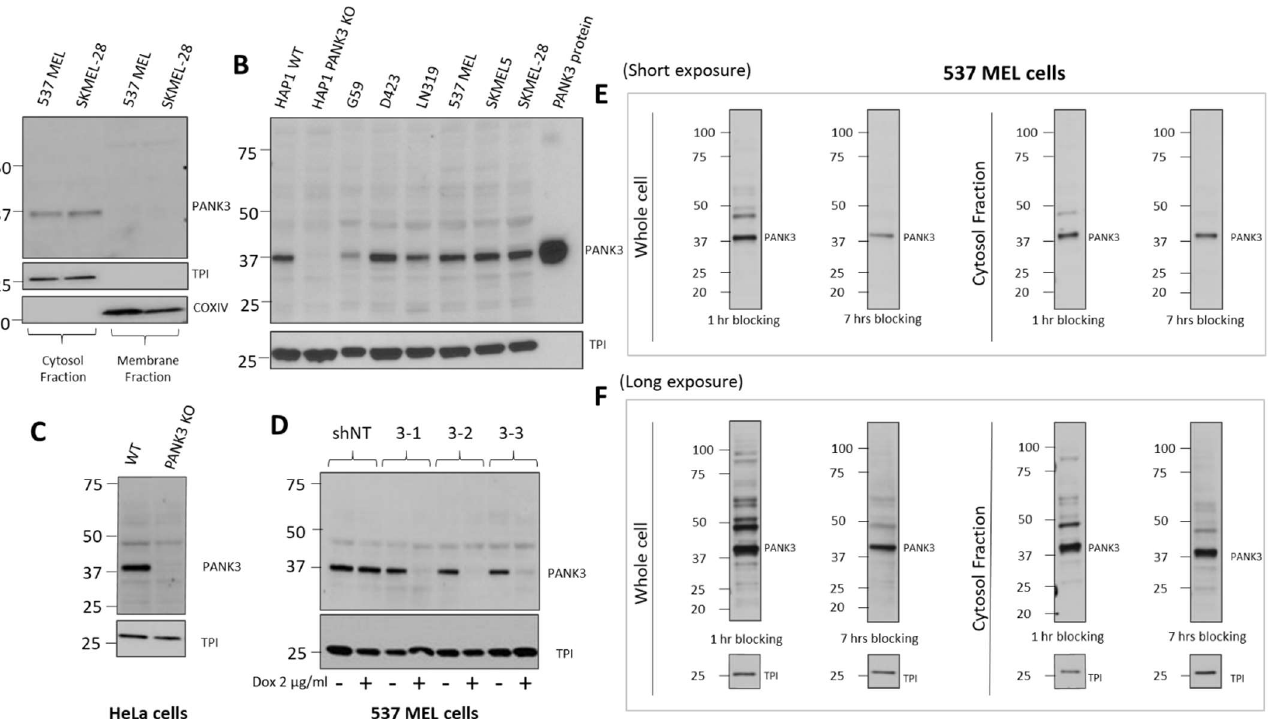
Figure 5. Optimization of PANK3 specific detection by subcellular fractionation of cells and longer blocking of transferred membranes. ( A ) Immunoblots showing that PANK3 protein is found exclu- sively in the cytosolic fraction, confirming the cytosolic distribution of PANK3 protein in human cells. B. MDA-299-62A can detect the recombinant PANK3 protein (positive control) and endogenous PANK3 protein in cytosolic fractions of specified cancer cell lines. HAP1 PANK3 CRISPR KO ( B ) and HeLa PANK3 KO ( C ) cell lines were used as negative controls to verify the correct band specificity. ( D ) Knockdown of PANK3 protein by dox-inducible shRNA, determined by immunoblot on cytosolic protein fractions using MDA-299-62A mouse monoclonal PANK3 antibody. ( E , F ) The PANK3 band was detectable on whole cell lysates and the interference by non-specific bands was significantly reduced by increasing the duration of blocking to 7 h instead of the typical 1 h. Both the whole cell lysates and cytosolic protein fractions are shown for reference, with shorter (15 s) and longer exposure (5 min) to the X-ray